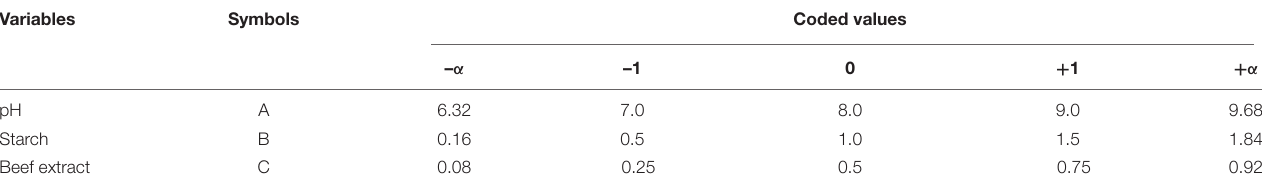
TABLE 3A | Independent variables and their ranges used in response surface methodology.